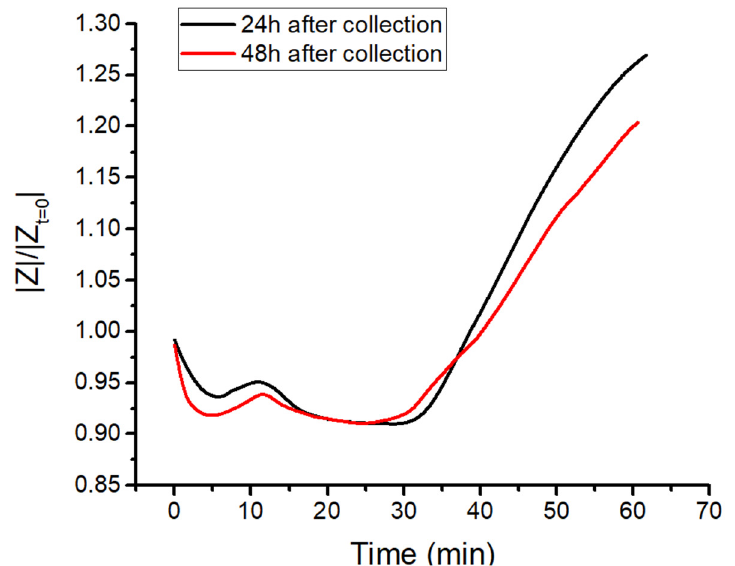
Figure 3. Impedance test of blood coagulation of the same donor’s sample tested 24 h (black curve) and 48 h (red curve) after